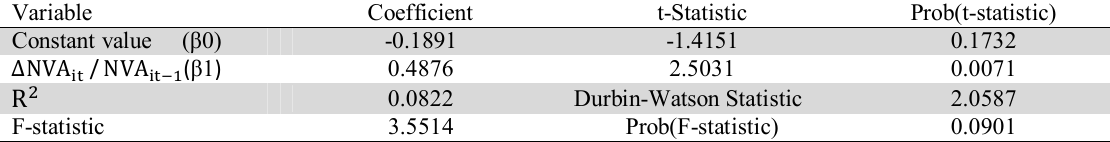
Results of the panel analysis to test the second hypothesis (H2) model